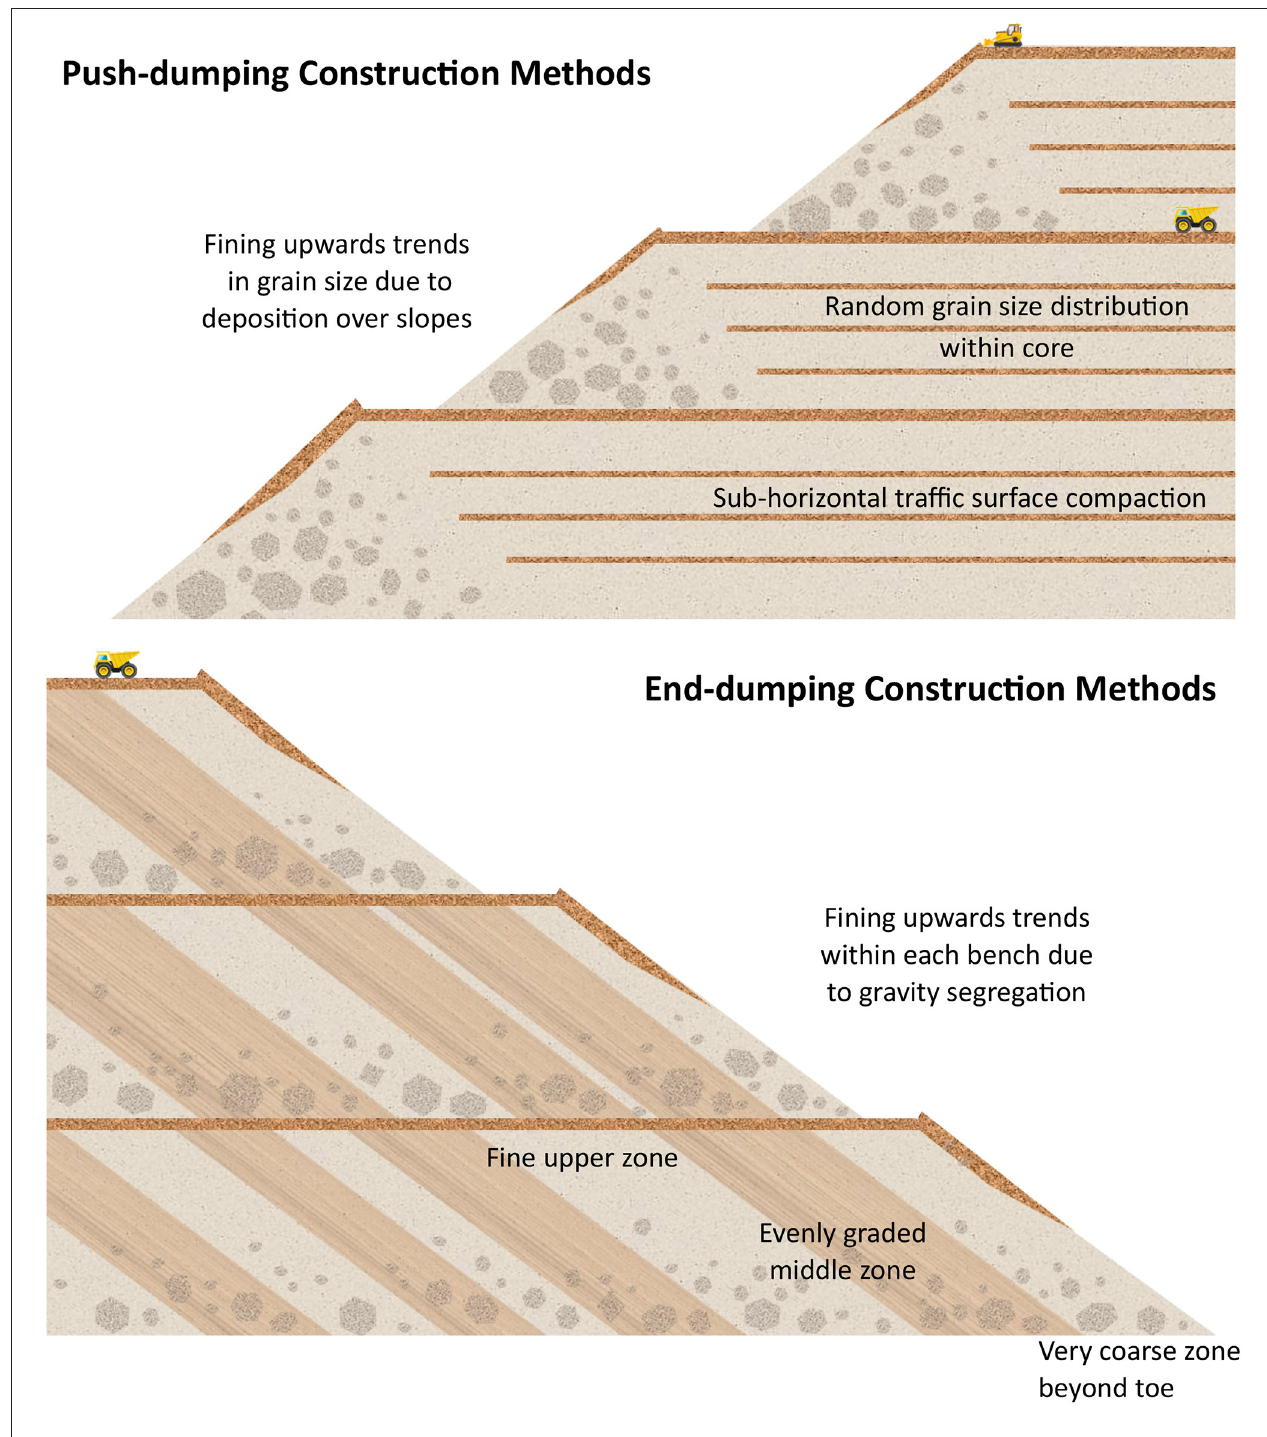
FIGURE 1 | Illustrated conceptual models of push- and end-dumping construction methods in a WRP. In the end-dumped pile, different patterns represent distinct materials emplaced along the angle of repose. Darker layers at the top of each bench in the end-dumped pile or within the center of the push-dumped pile represent compacted traffic